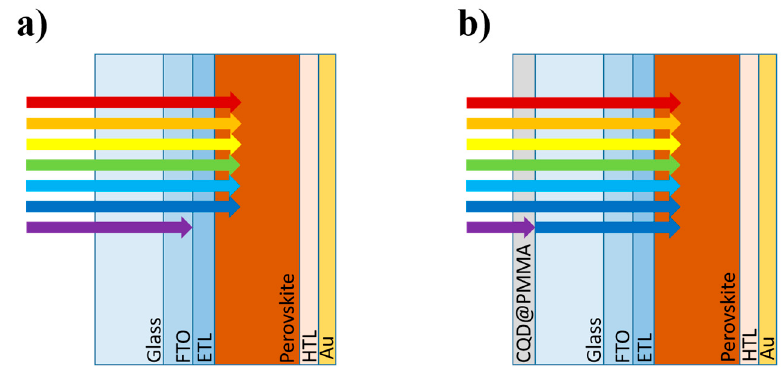
Figure 1. Schematic image of perovskite solar cells (PSCs) ( a ) without and ( b ) with the poly(methyl methacrylate) with embedded carbon quantum dots (CQD@PMMA) coating used for improving light harvesting in a PSC due to the down-conversion effect.